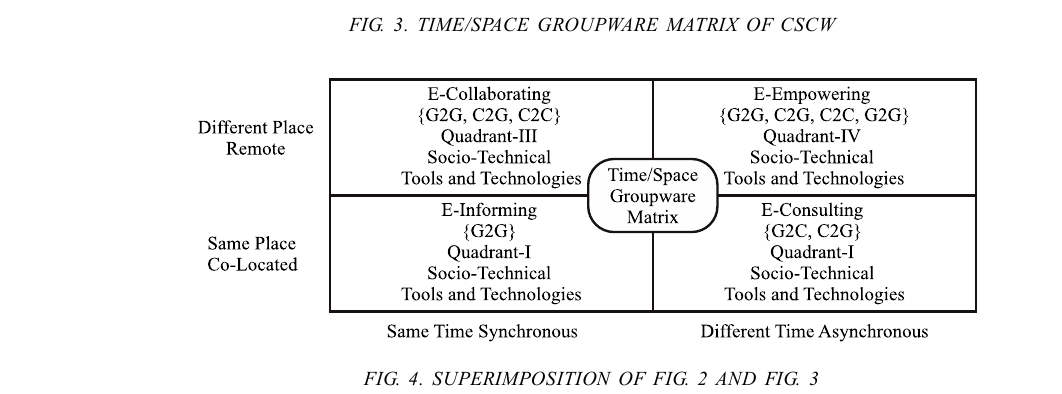
FIG. 4. SUPERIMPOSITION OF FIG. 2 AND FIG.